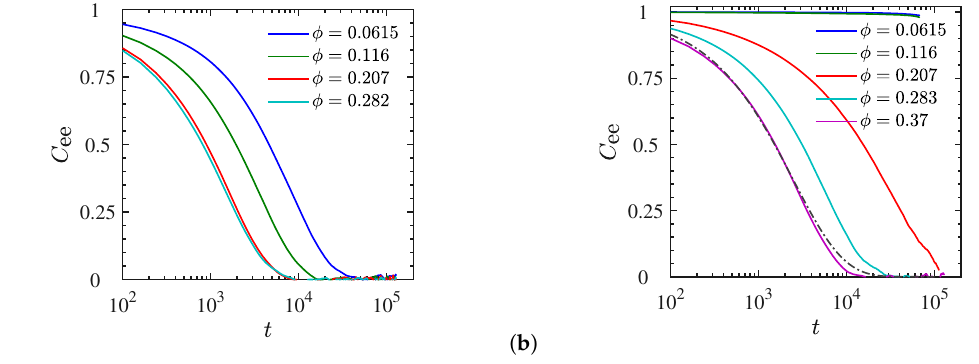
Figure 6. Chain end-to-end vector autocorrelation function C ee ( t ) of ( a ) end-charged and ( b ) p3-charged N = 40 chains for dispersed systems at various NP volume fractions. Dash-dotted line in ( b ) shows the stretched-exponential fit to the numerical data of φ = 37%. In every case C ee ( 0 ) =